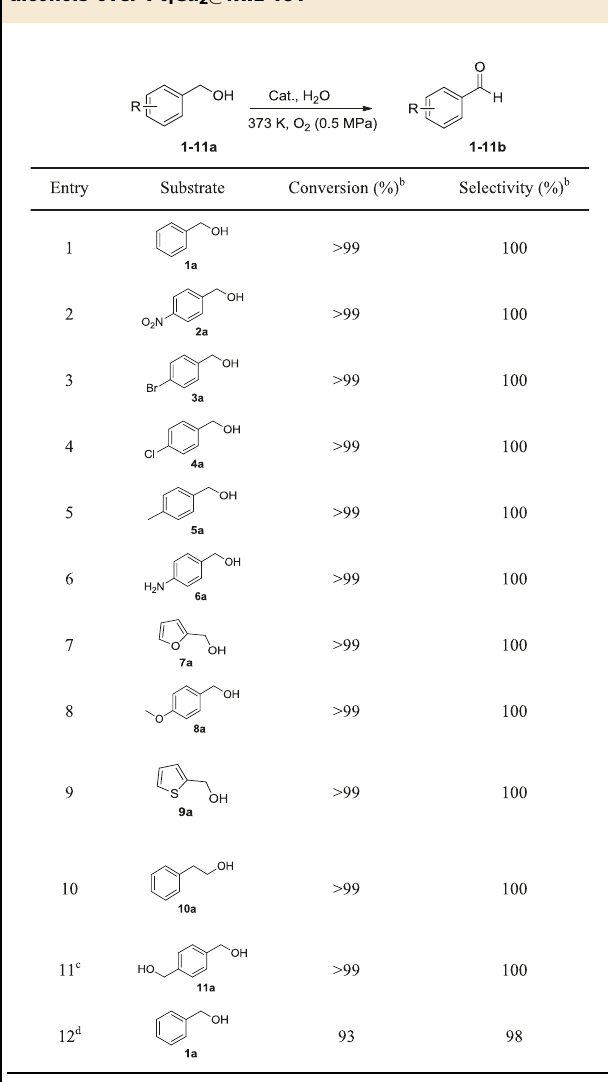
Table 2 Selective aerobic oxidation of various aromatic alcohols over Pt 1 Cu 2 @MIL-101